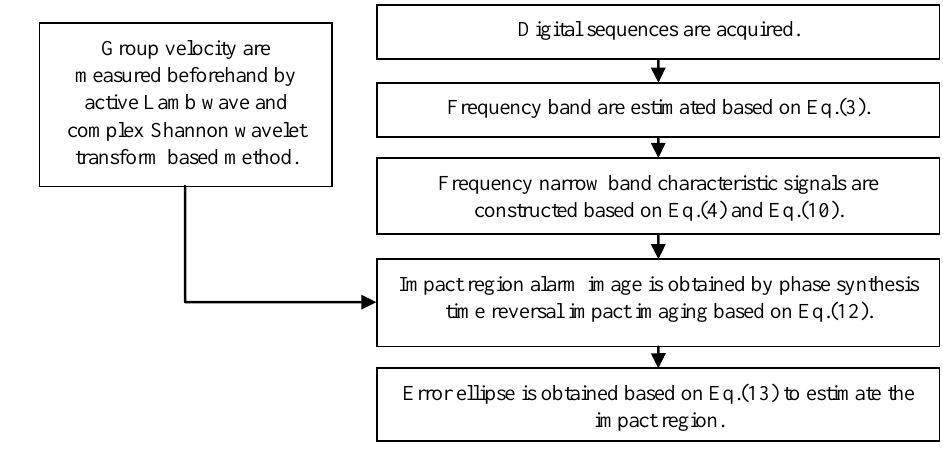
Figure 13. Implementation process of the impact alarm region imaging